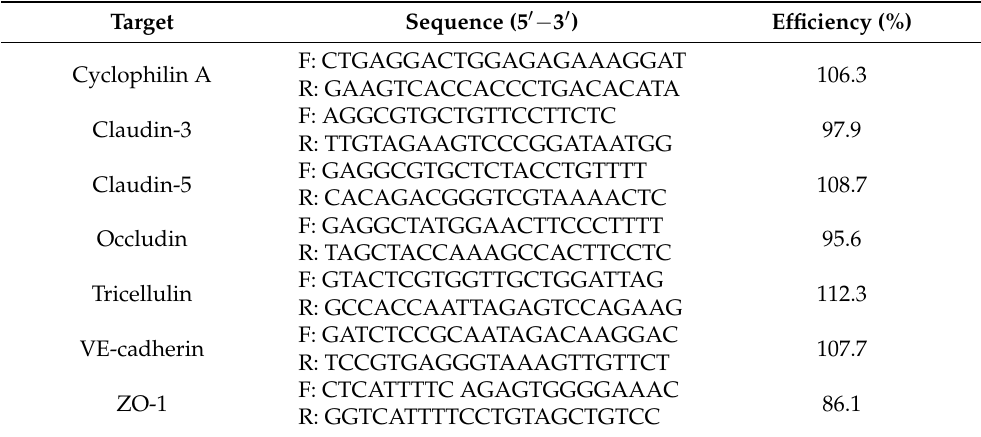
Table 2. Nucleotide sequences of primer pairs used for qPCR. F: forward (forward primer); R: reverse (reverse primer). VE-cadherin: vascular endothelial-cadherin; ZO-1: zonula